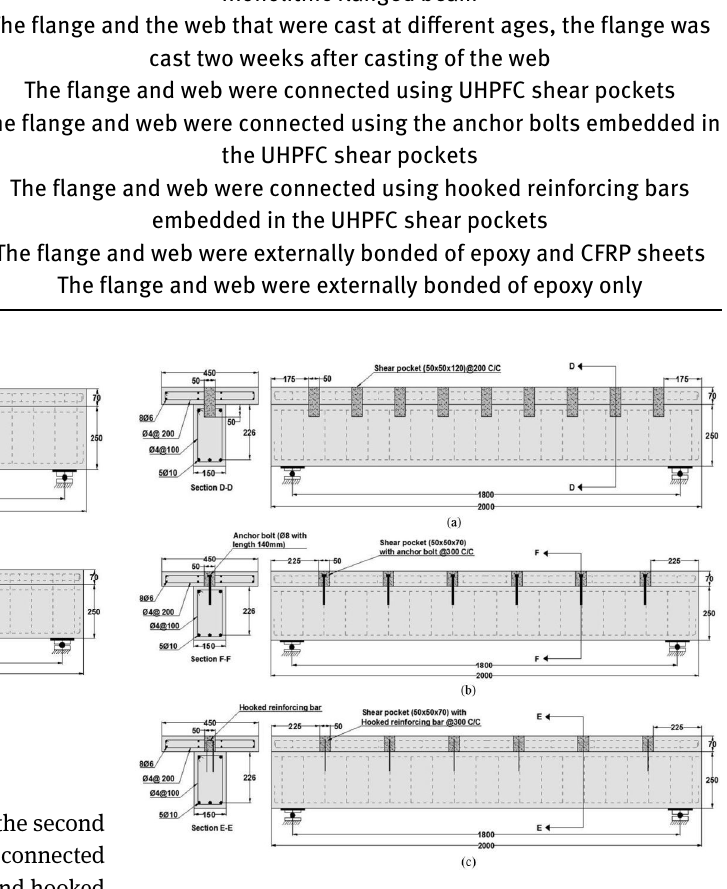
Figure 2: Details of the mechanical connecting specimens (a) PB3;